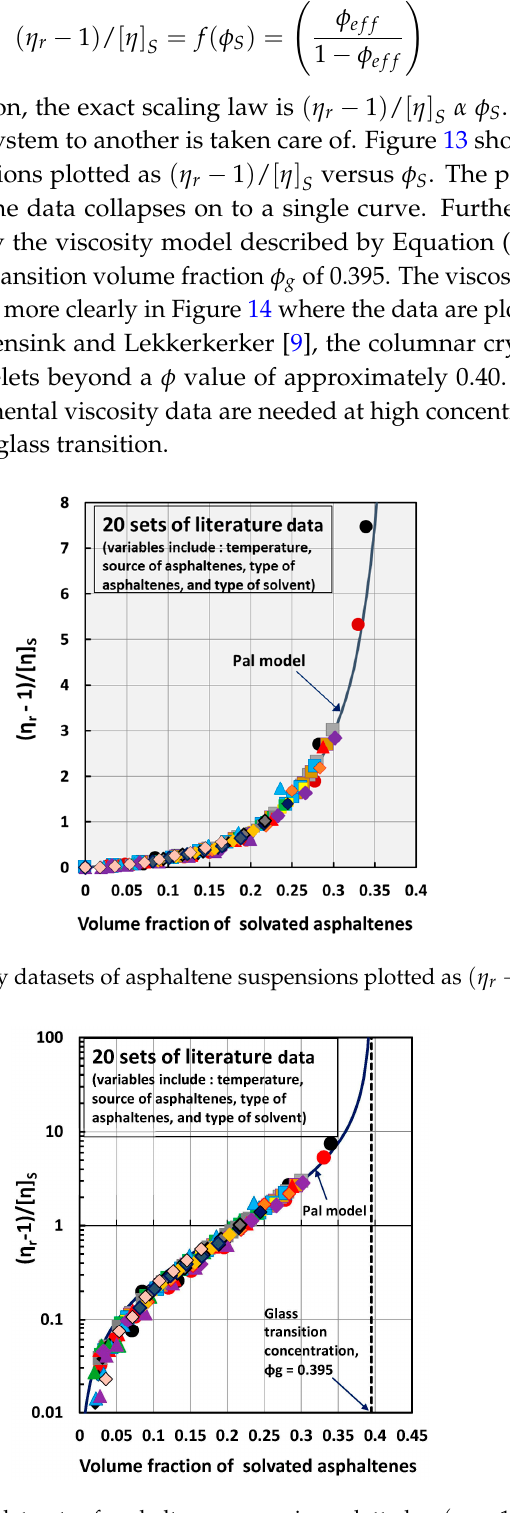
Figure 14. Twenty viscosity datasets of asphaltene suspensions plotted as Sr ]/[)1( ηη − versus S φ on a semi-log scale.